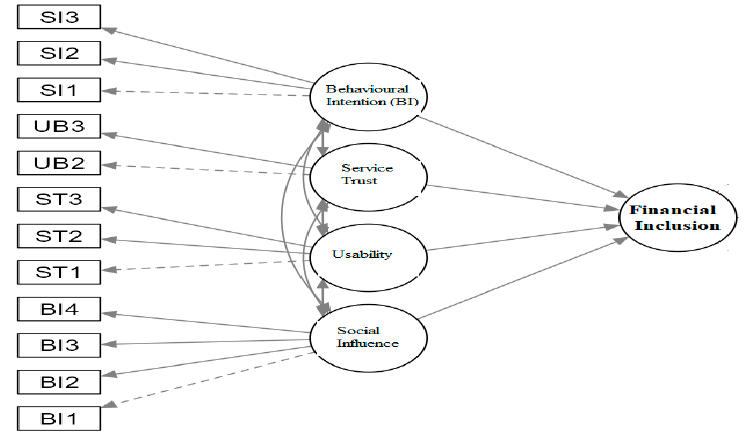
Figure 1. Conceptual framework.